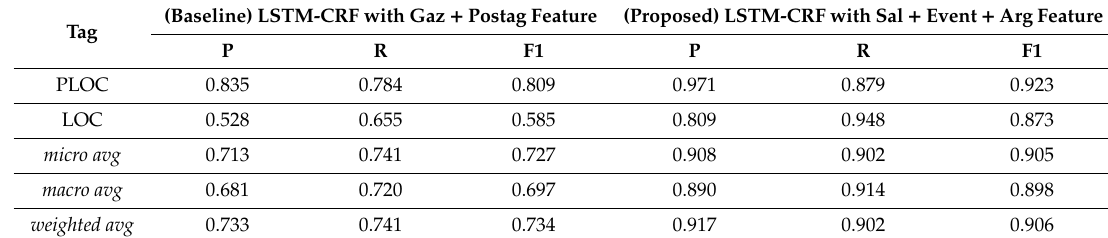
Table 9. Pseudo-location identification (step 5).